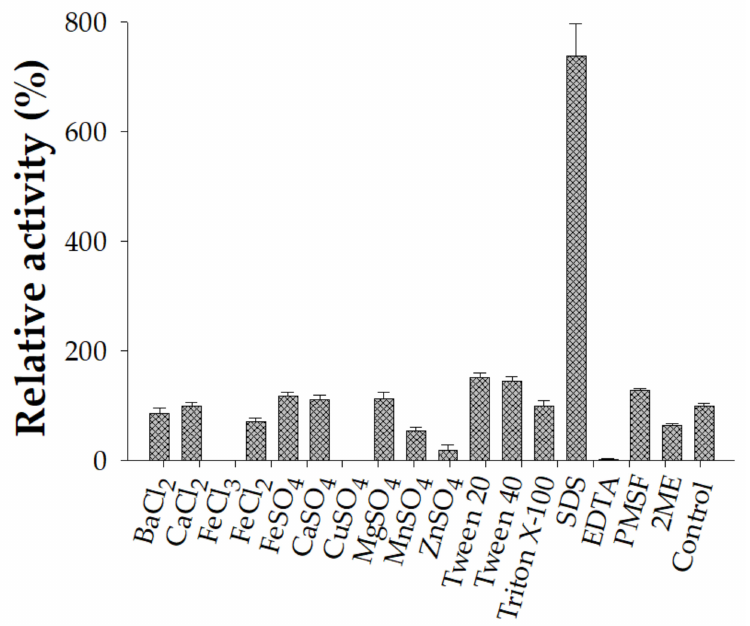
Figure 5. Effect of chemicals on the proteolytic activity of Streptomyces speibonae TKU048 (cid:48) s crude- enzyme cocktail. The relative activity of the protease was 100% = 83.33 ± 3.17 U/mL. The protease activity without added chemicals (control) was defined as 100%. All data points are means ± S.D. of three different experiments (each experiment was conducted in